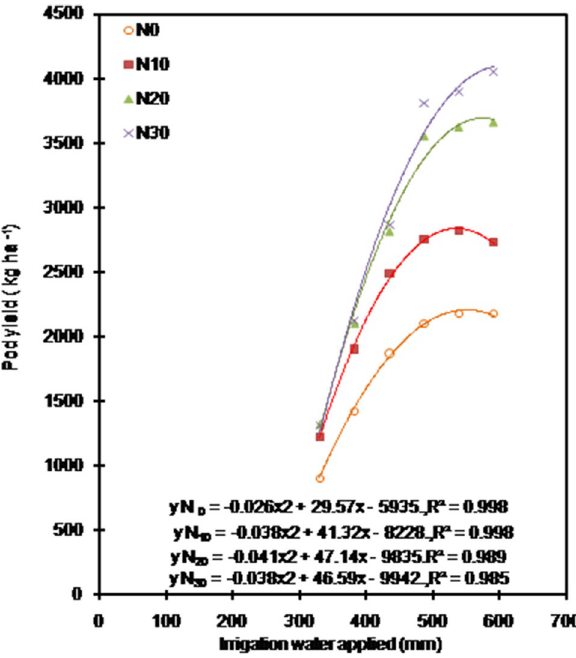
Figure 5. Relationship between irrigation water applied and pod yield of peanut under different N application rates during 2012–2014 at Bikaner, India. Each data point is average of 9 values. N 0 : 0 kg N ha −1 ; N 10 : 10 kg